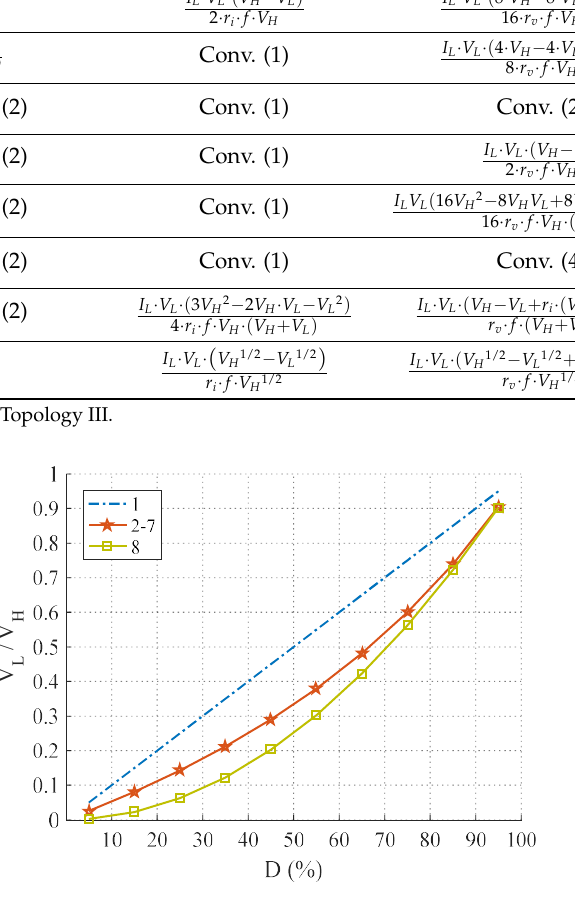
Figure 6. Voltage conversion ratios for the compared DC–DC converters (converters 1–8 described in Table 1).